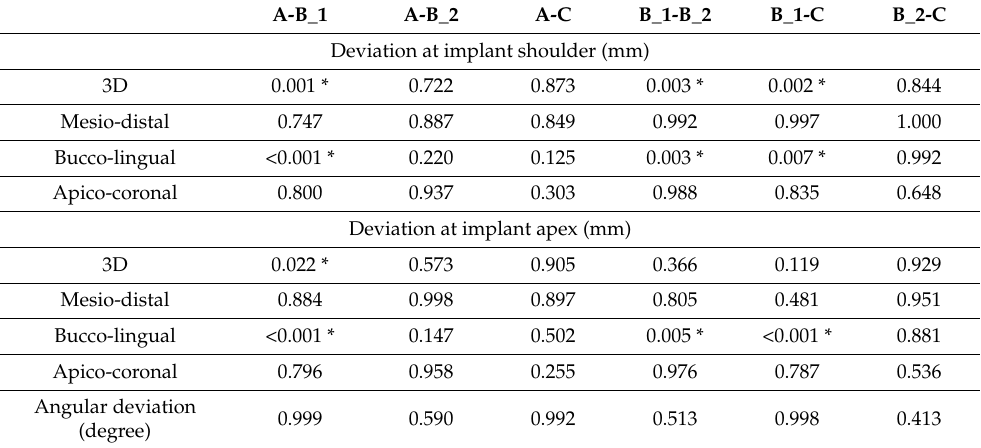
Table 4. Comparison of the deviations achieved by each process chain.